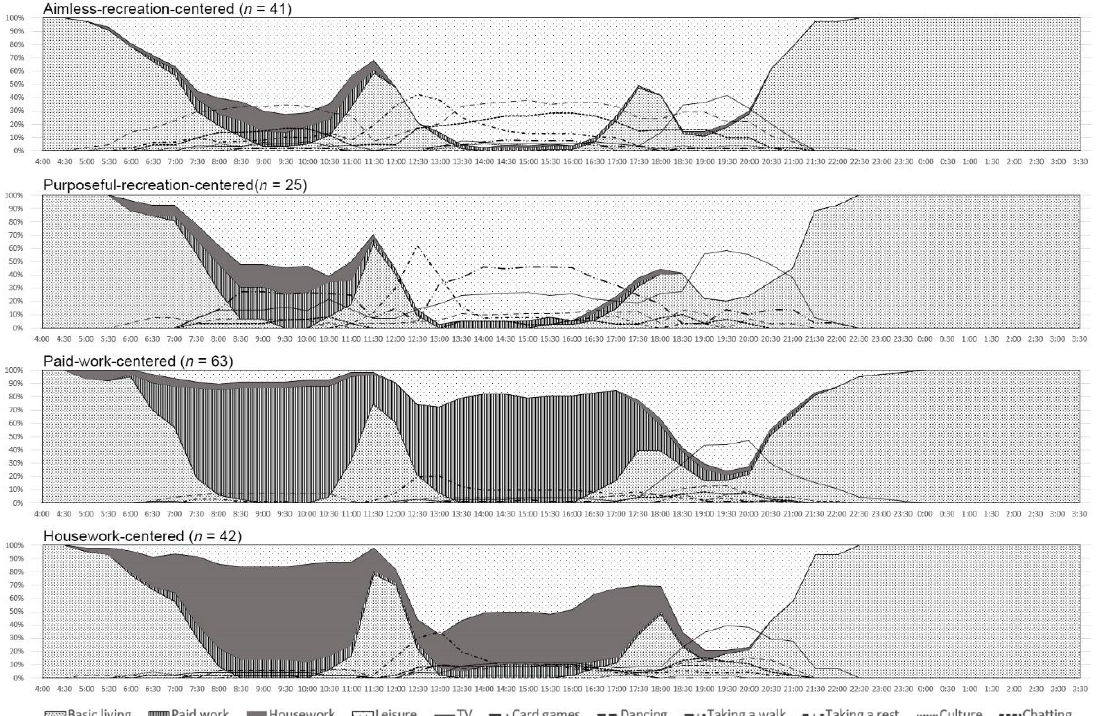
Figure 4. Four patterns according to daily activities (the numerical value of each time point is the proportion of people doing a certain activity in this